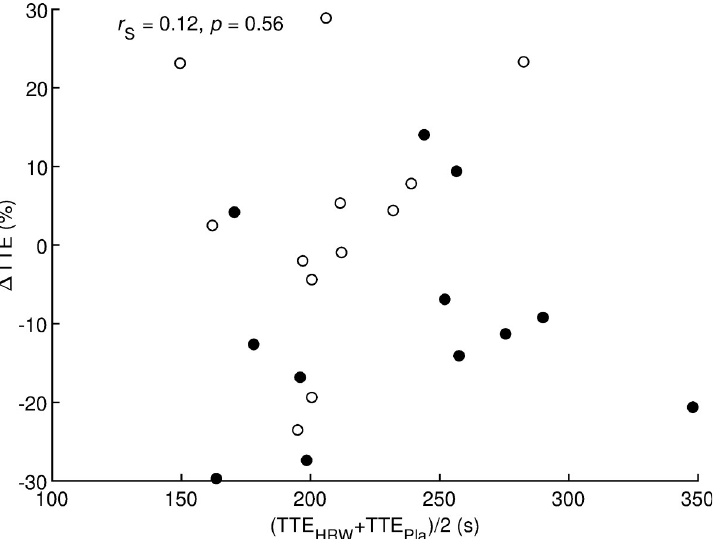
Fig 4. Correlation analysis between effect of hydrogen rich water on time to exhaustion and pooled time to exhaustion. r S = Spearman’s correlation coefficient; p = statistical significance of correlation coefficient; Δ = difference between hydrogen rich water and placebo; TTE = time to exhaustion; HRW = hydrogen rich water; Pla = placebo. Filled and open circles indicate runners who received HRW and placebo, respectively, in the first